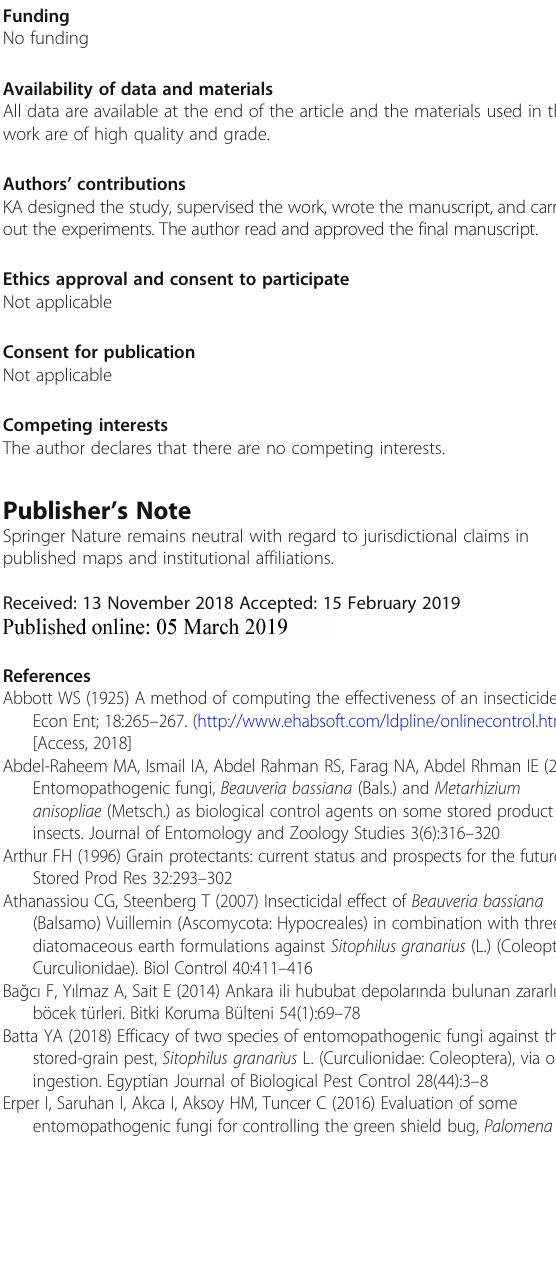
*The same small letters within columns indicates no significant differences between means **The same capital letters within rows indicates no significant differences between means ***TR-01 ( Simplicillium lamellicola ), TR-07 ( Lecanicillium muscarium ), TR-78-3 ( Isaria fumosorosea ), TR-106 ( Metarhizium anisopliae ), and TR-217 ( Beauveria bassiana